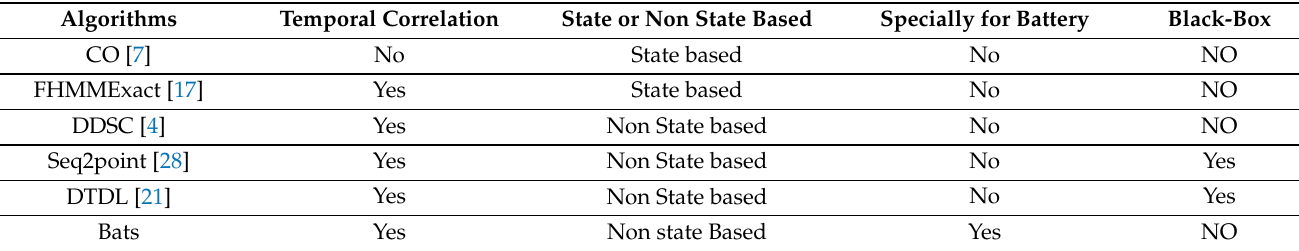
Table 7. Comparison of several algorithms.